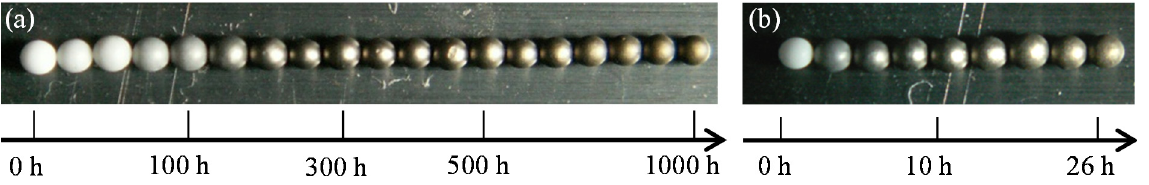
Figure 5. Appearance of Al 2 O 3 balls by MCT. ( a ) By pot mill; ( b ) By planetary ball mill